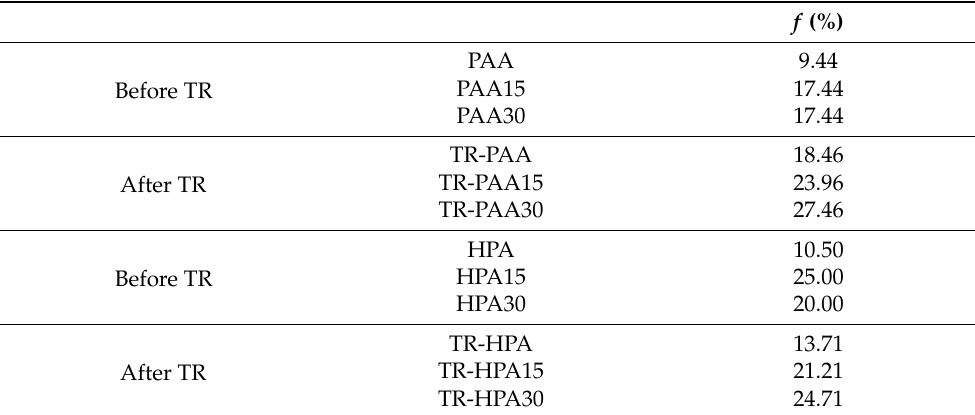
Table 6. Free volume fractions according to